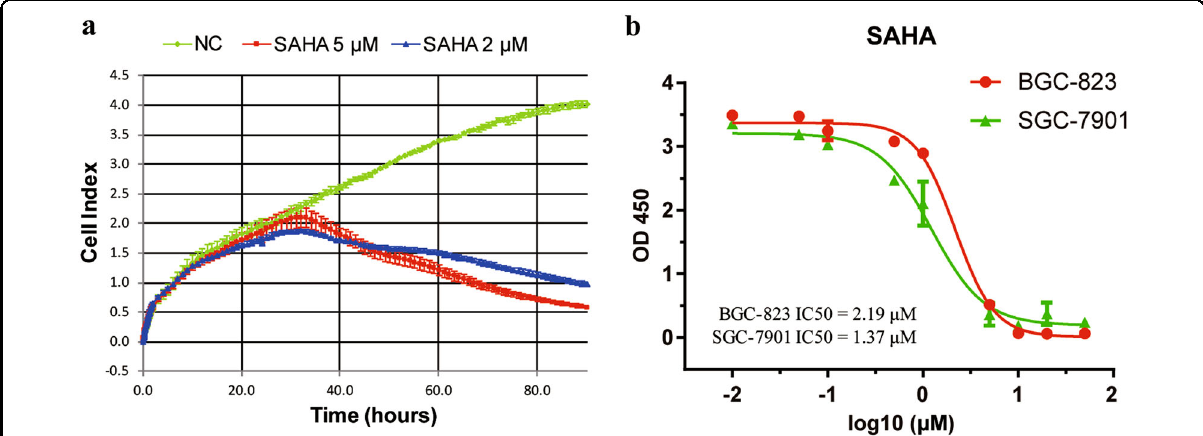
Fig. 1 The effect of SAHA on the proliferation of gastric cancer cells. a A real-time cell proliferation assay using the xCELLigence system showed that SAHA treatment induced the death of BGC-823 cells in both a concentration- and time-dependent manner. b Determination of the IC50 of SAHA in BGC-823 and SGC-7901 GC cells treated with SAHA for 72